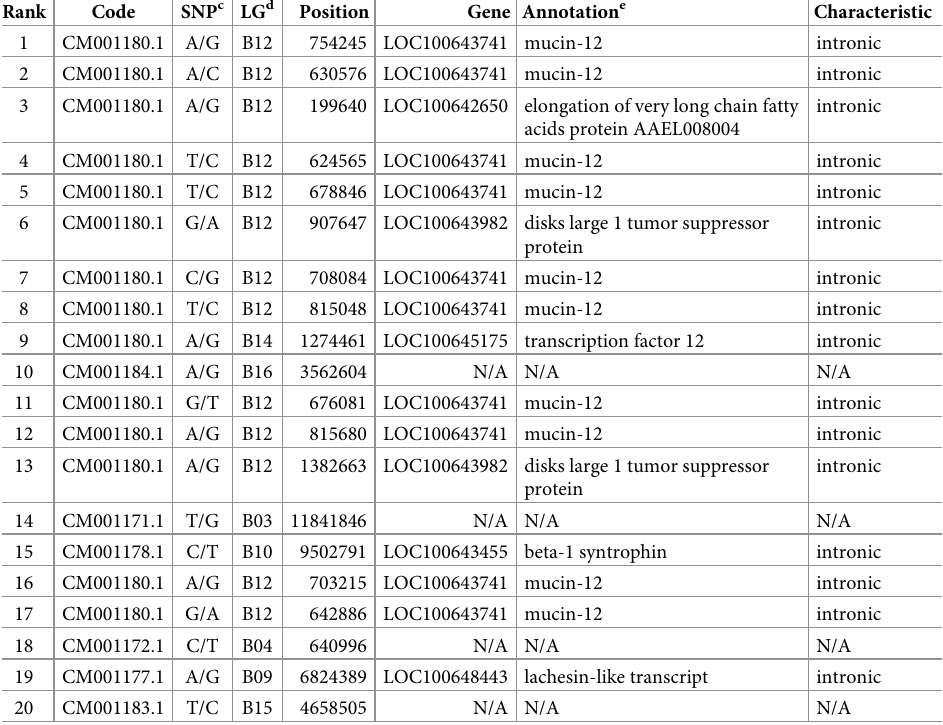
Table 3. GWAS from high-coverage study (8 x 8matrix).